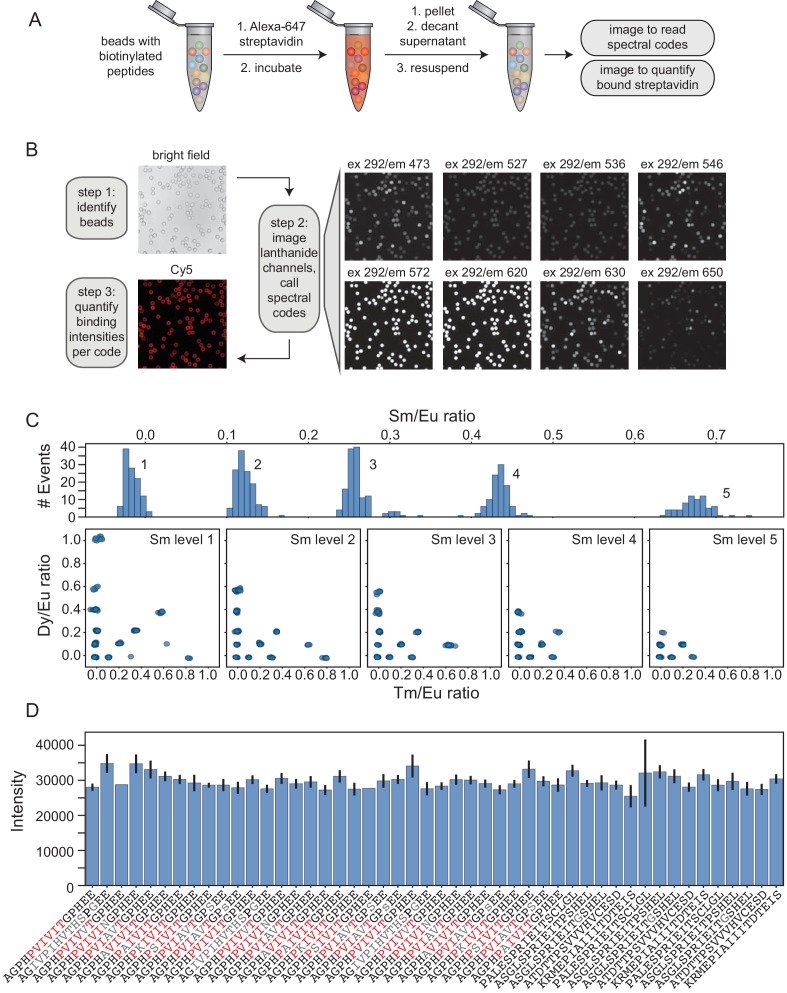
Streptavidin binding assay reveals any sequence-specific differences in peptide synthesis efficiency.(A) Experimental pipeline for streptavidin binding assay. MRBLE peptide libraries are biotinylated, incubated with Alexa-647-labeled streptavidin, washed, and imaged to identify embedded spectral codes and peptide sequences associated with each bead as well as quantify the amount of bound streptavidin. (B) Example images showing Alexa-647-labeled streptavidin binding to biotinylated MRBLE libraries and image processing steps. (C) Histograms and scatter plots of MRBLE Sm/Eu, Dy/Eu, and Tm/Eu ratios showing 48 clearly resolved intensity clusters and resolvable spectral codes. (D) Measured bound streptavidin intensities (median ± standard error on the mean) for an example 48-code library containing multiple systematic variants of candidate calcineurin substrates.